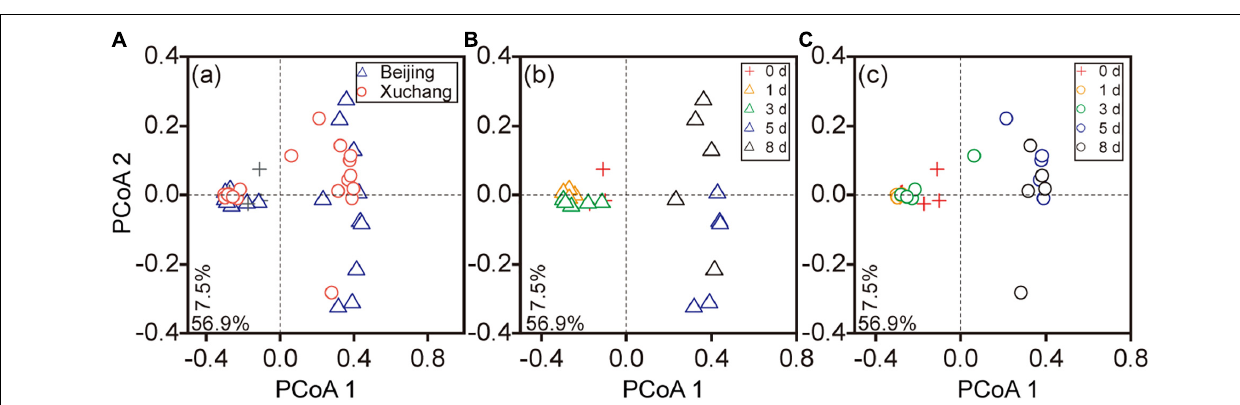
FIGURE 4 | The principal coordinate analyses (PCoAs) based on the Bray–Curtis distance of bacterial communities at different sampling times. Triangles indicate the samples in native soil (Beijing), circles indicate those in non-native soil (Xuchang), and the crosses indicate the samples in native soil and non-native soil at day 0. PCoA of bacterial communities in native and non-native soil treatments (A) . Decomposition time had a significant effect on bacterial community composition in native soil ( B , p < 0.01) as well as in non-native soil ( C , p <